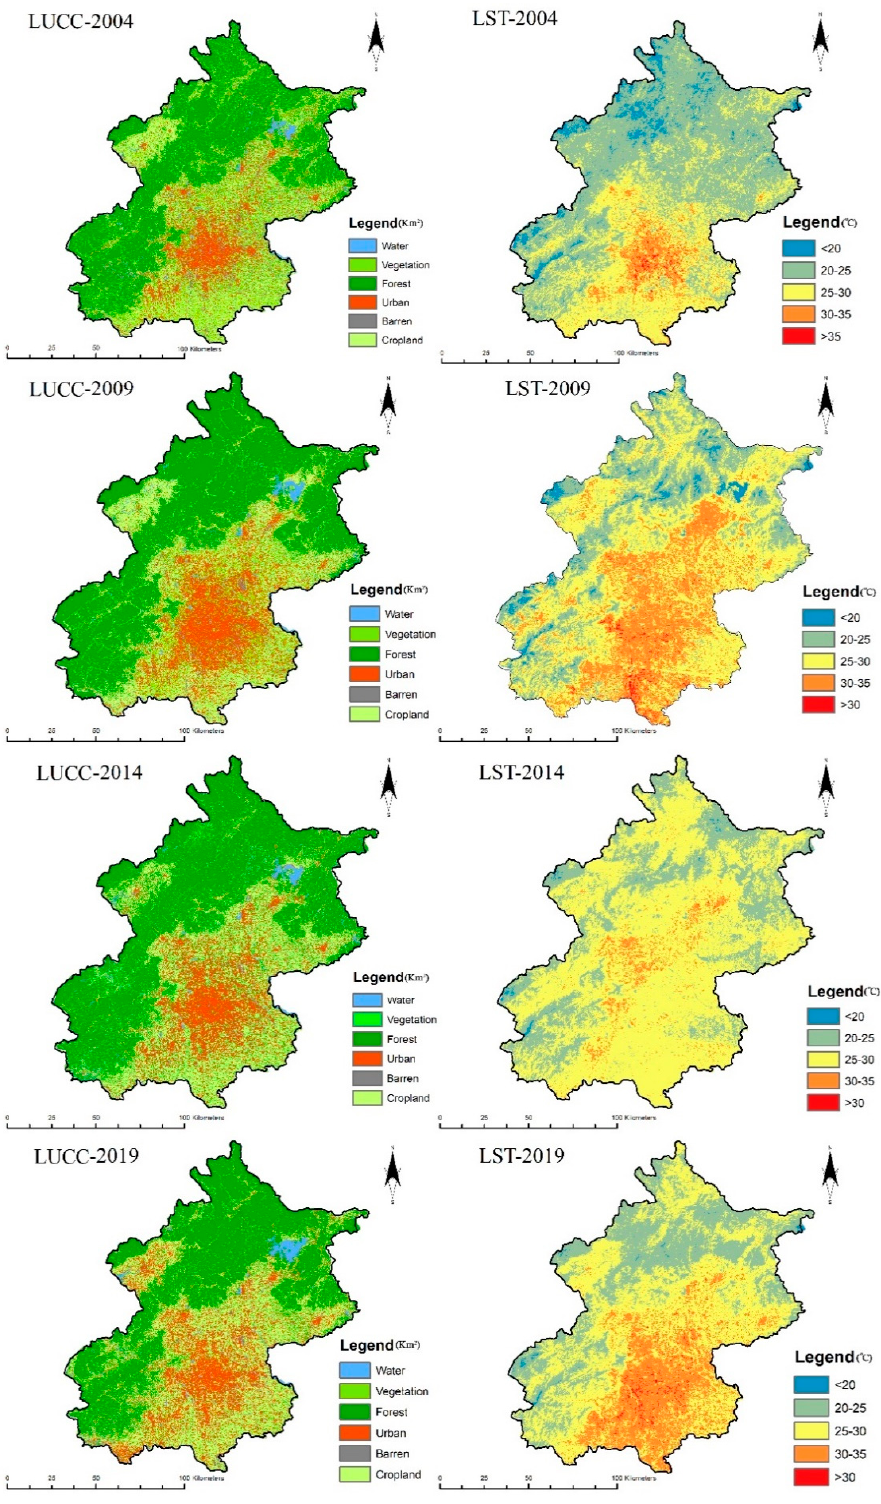
Figure 3. Spatial distribution maps of land use and land cover and land surface temperature of Beijing.